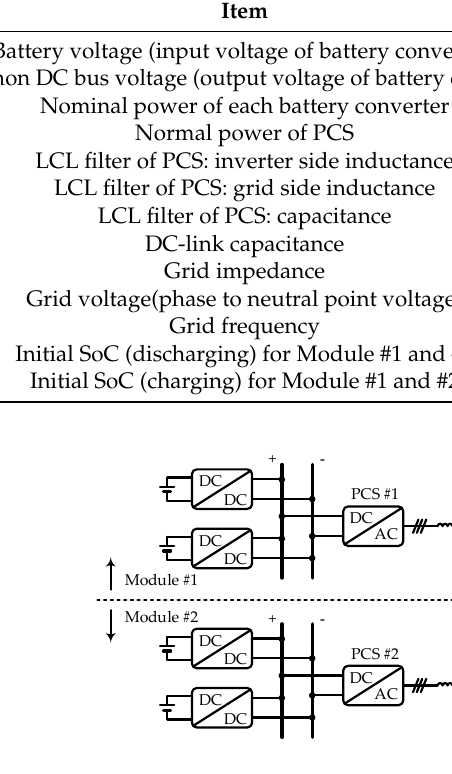
Table 1. System parameters.